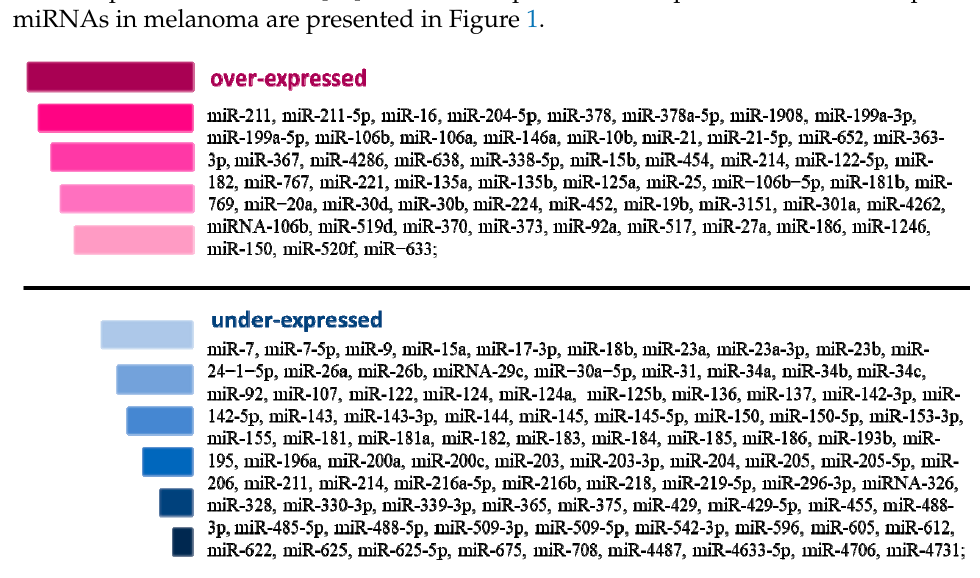
Figure 1. MicroRNAs in CMM melanoma. The figure shows lists of under-expressed and over-expressed miRNAs in cutaneous malignant